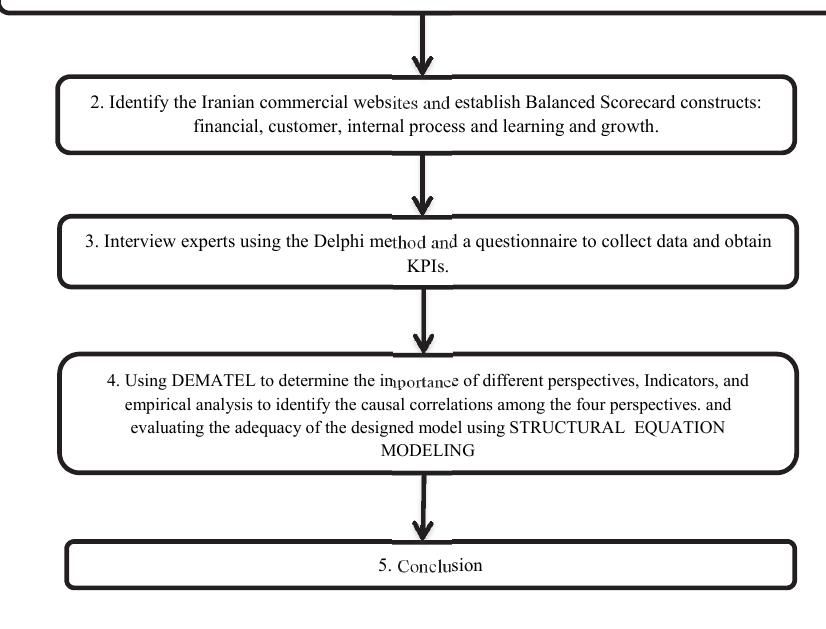
Fig. 1 . Study flow chart